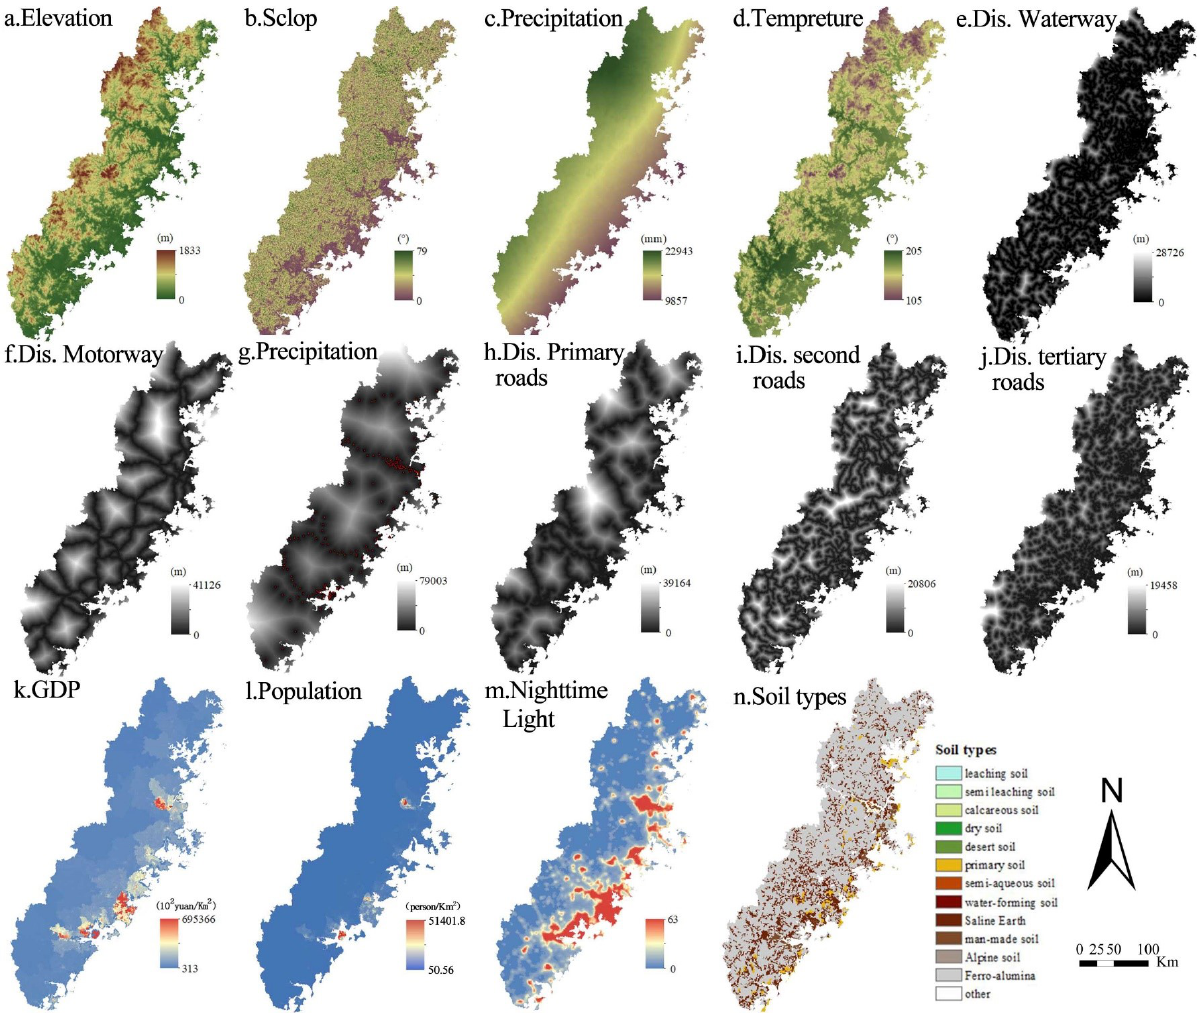
Figure 3. Drivers of LUCC conversion in Fujian coastal areas.